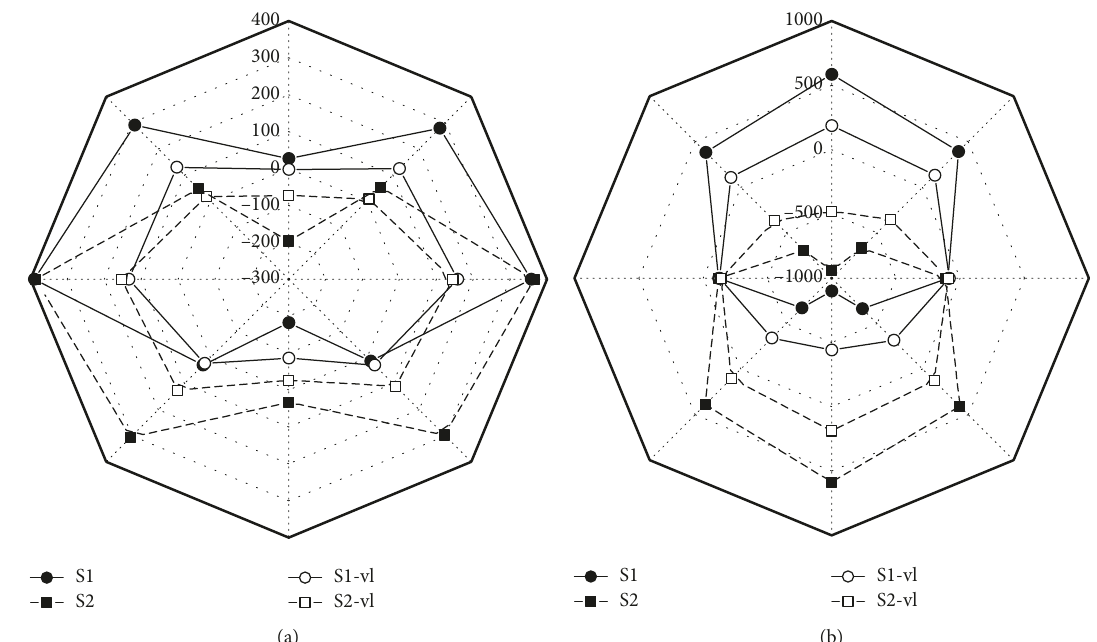
Figure 13: (a) Hoop force and (b) longitudinal axial force (kN/m) in the lining of the existing tunnel at the end of tunnel excavation of S1 and